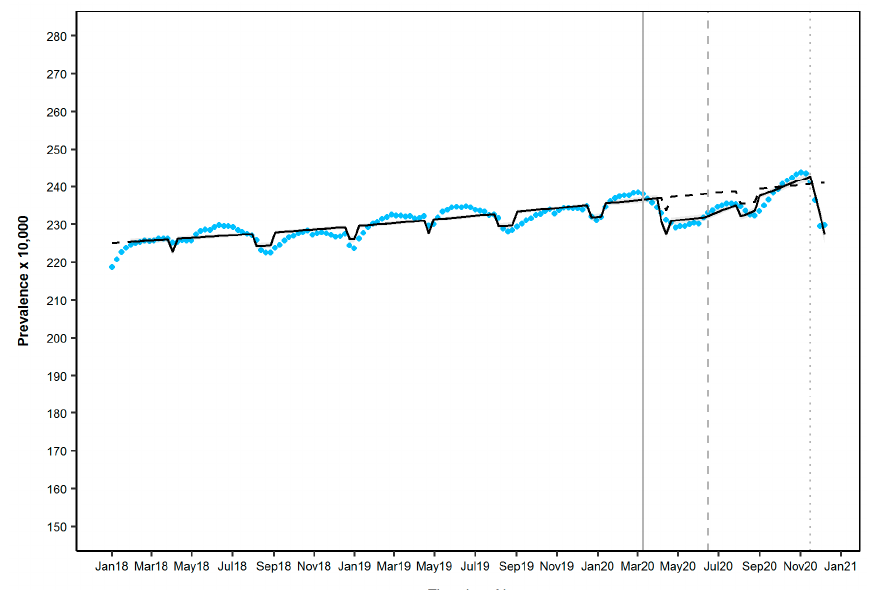
Figure A1. Time series analysis of anti ‐ seizure medication (ASM) prevalence considering a 60 ‐ day grace period between different periods: Pre ‐ Lockdown, First ‐ Lockdown, Post ‐ Lockdown and Second Lockdown. Legend: Light blue dots: observed incidence of AEs drug use; solid line: predicted model based on observed outcome; Grey zone: 95%CI of the predicted model; Dashed line: expected scenario in the absence of LMI; Vertical solid line: First Lockdown (First LMI date); Vertical dashed line: Post ‐ Lockdown (reopening date); Vertical dots line: Second Lockdown (Second LMI date). The fitted model was the form: Log[E(Yi)] = − 3.761 + s(weeki, k = 4)–0.015 (holidayi)–0.027 (Lag 4 First lockdowni) + 0.002 (pot ‐ lockdown weeki)–0.024 (Lag 1 Second lockdown weeki).